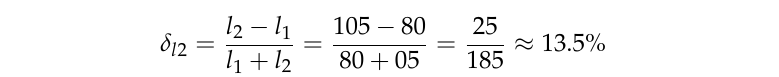
Figure 13. Schematic diagram of the different deviations.